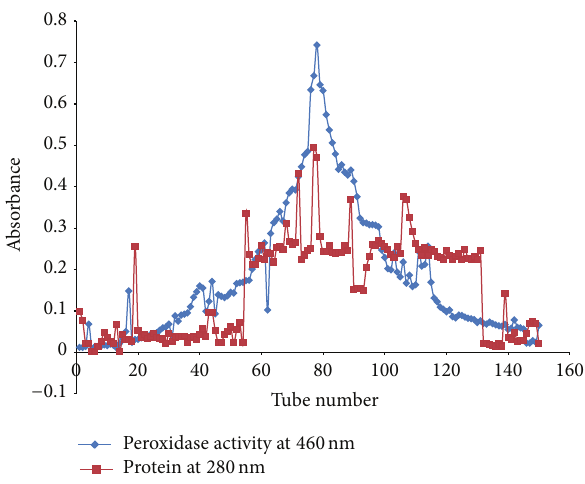
Figure 1: Gel filtration chromatography elution profile.